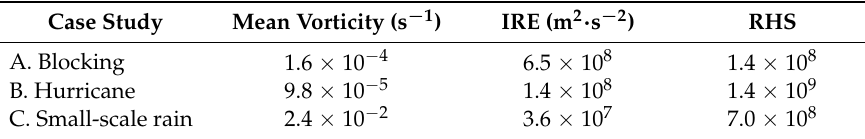
Figure 3. The ( a ) track of Hurricane Patricia (see: [32] ); and ( b ) a visible satellite image near the time of maximum intensity at 1500 UTC 23 October 2015.